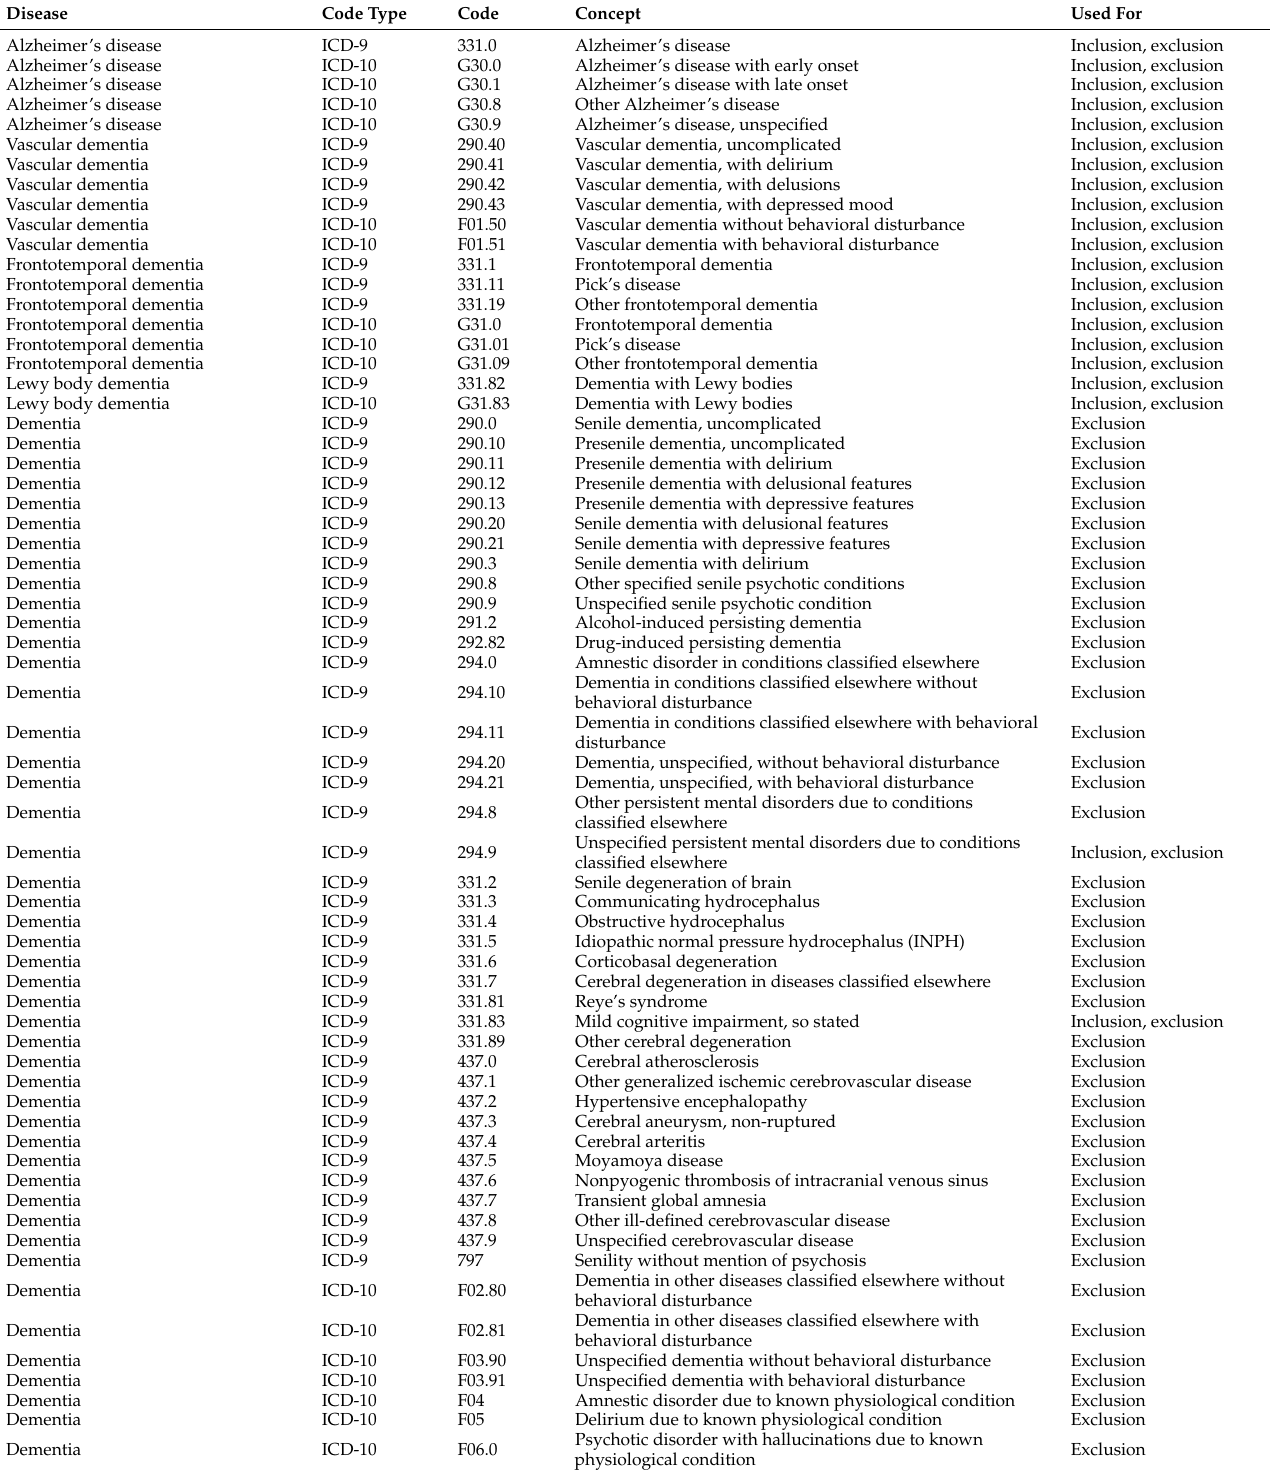
Table A1. ICD code set for ADRD